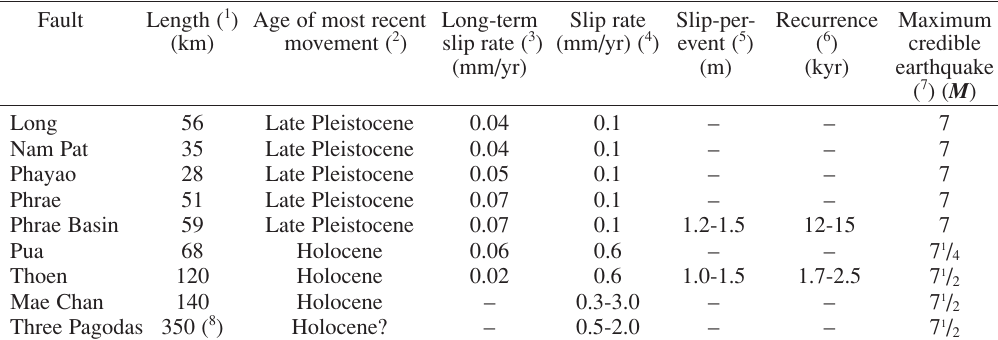
Table I. Seismic source parameters of active faults in Northern and Western